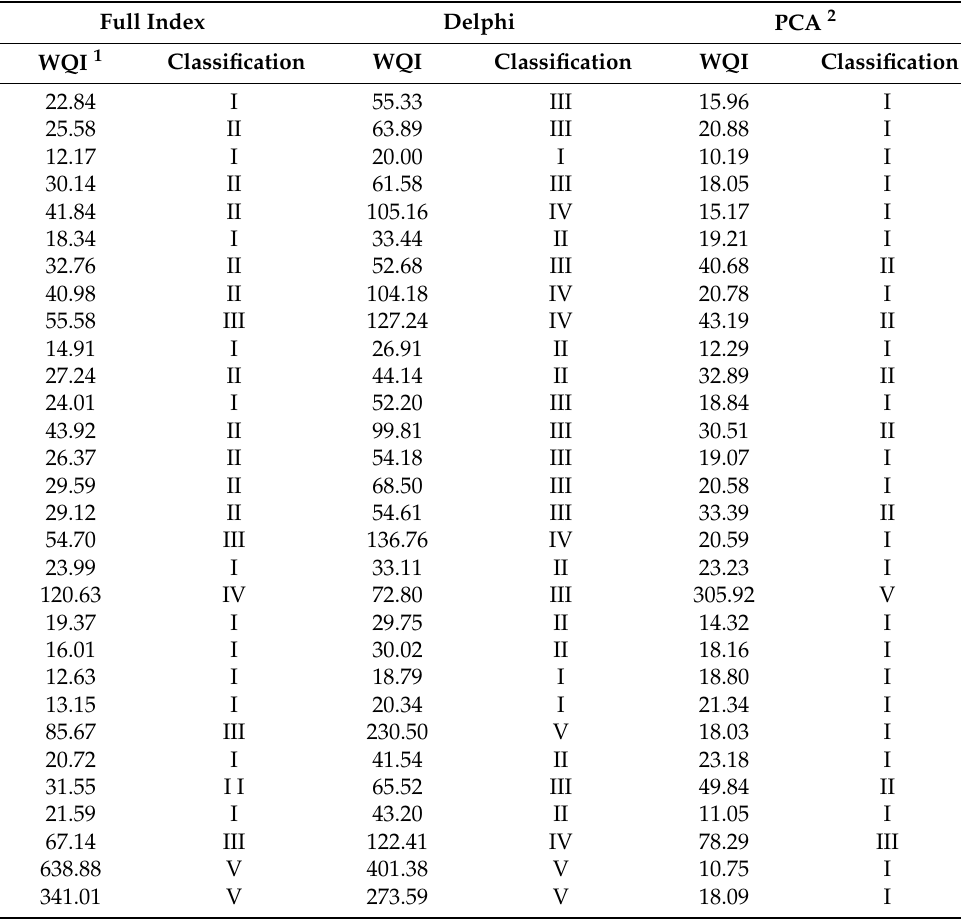
Table 6. Sample wells classification